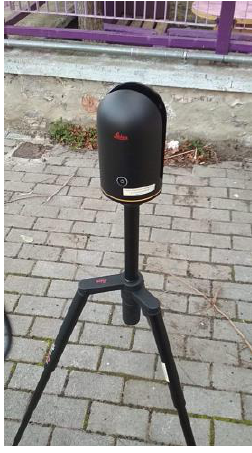
Fig. 1. The BLK360 laser scanner during data collection